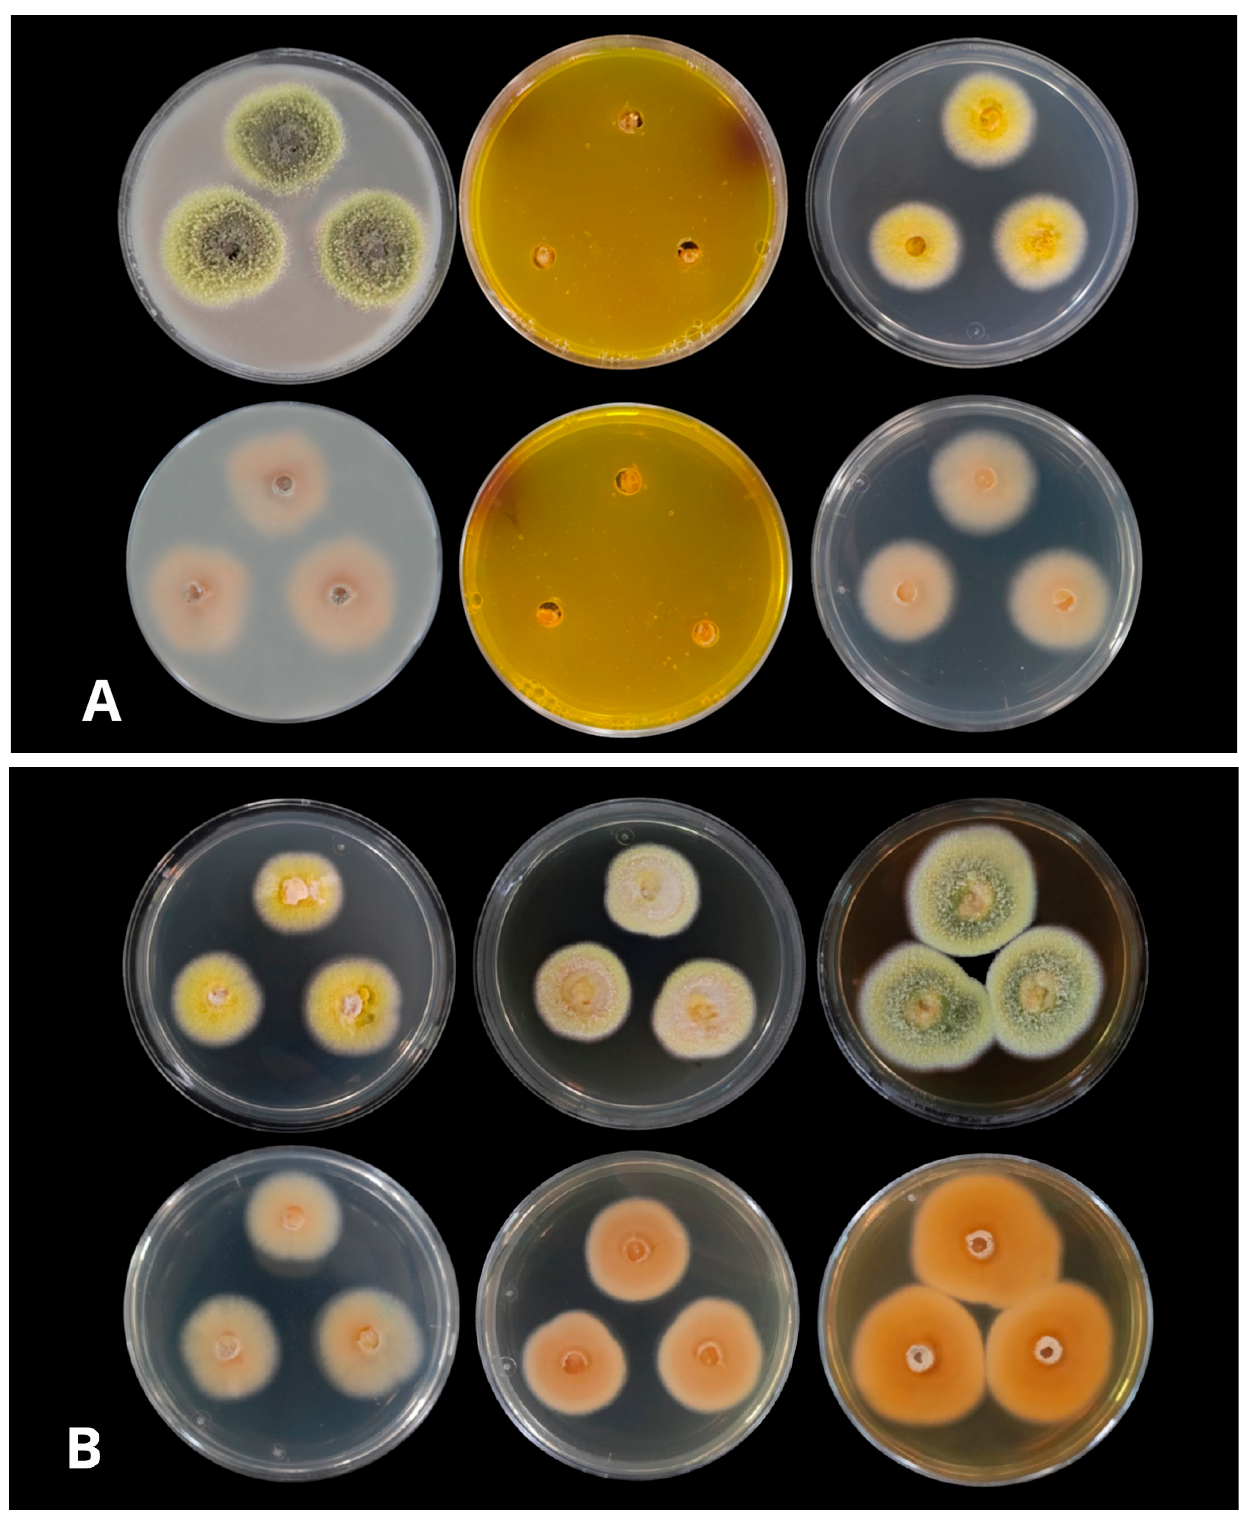
Figure 2. ( A ): Colonies from left to right (top row) OA, CREA, CYA supplemented with 5% NaCl (CYAS), (bottom row) OA reverse, CREA reverse, and CYA supplemented with 5% NaCl (CYAS) reverse ( B ): Colonies from left to right (top row) CYA, YES, Malta (bottom row) CYA reverse, YES reverse, and Malta reverse at 25 °C after 1-week incubation.